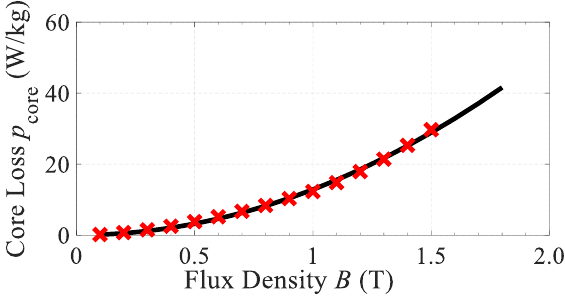
Figure 4. Core loss curve at 400 Hz of NGO 35JN200 electrical steel.